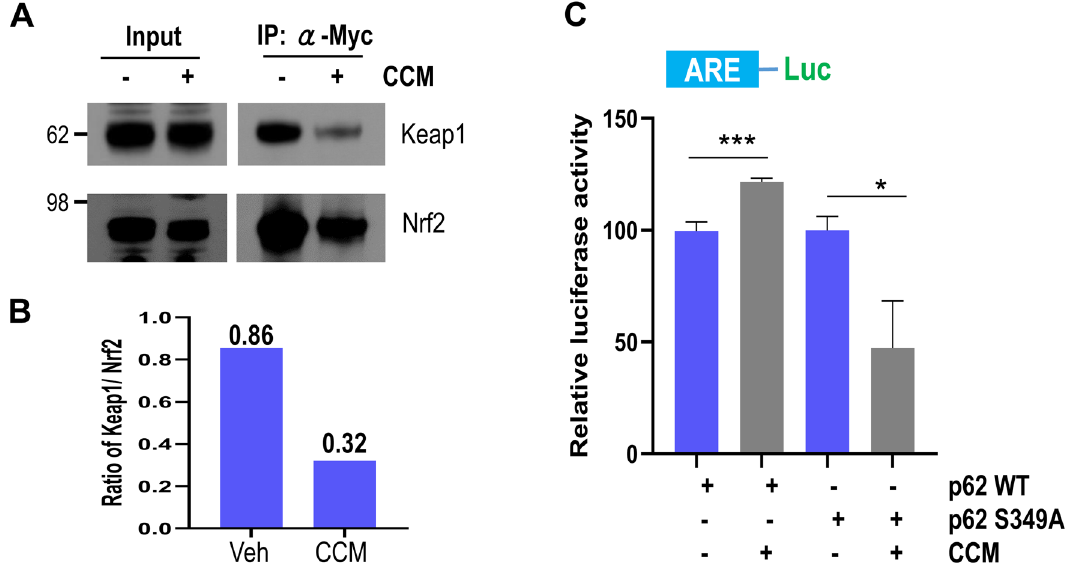
Figure 4. Curcumin-mediated Nrf2 activation is dependent on the phosphorylation of p62 on S351. ( A ) HEK293 cells were transiently transfected with the Myc-Nrf2 expression plasmid, and then treated with DMSO (−) or 10 μM curcumin (+) for 12 h. The cell lysates were used for Nrf2 immunoprecipitation using an anti- Myc antibody. The protein level of Keap1 co-immunoprecipitated with Nrf2 was examined by immunoblotting using an anti-Keap1 antibody. Full blots are provided in Supplementary Fig. S11. ( B ) The bar graph shows the relative ratio of Keap1 against Nrf2 co-immunoprecipitated with the Myc antibody in cells treated with curcumin (CCM) or not. ( C ) HEK293 cells were transiently co-transfected with the ARE-Luc reporter and TK-Renilla plasmids along with the Myc-p62 wild-type or mutant (S349A) plasmid. After treatment with either DMSO (−) or 10 μM curcumin (+) for 12 h, the cells were assayed for the luciferase activity. Data shown are mean ± S.E. of three independent experiments and were analyzed using the Student’s t -test. ( *p < 0.05, ***p <